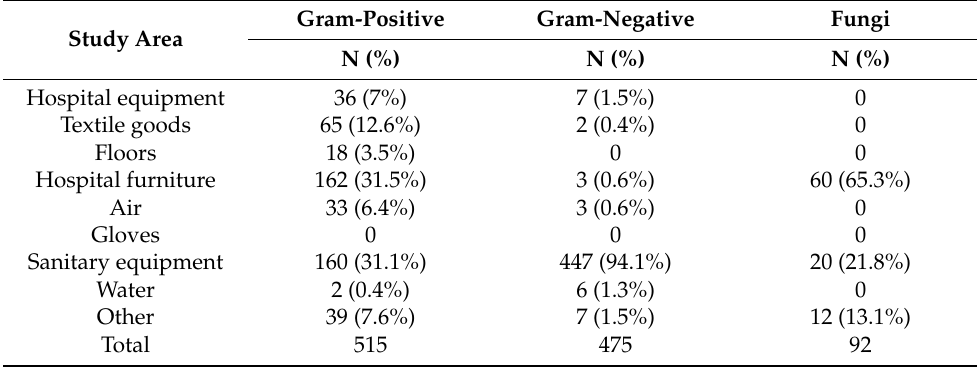
Table 3. Sampling site distribution by the type of the microorganism 1 .